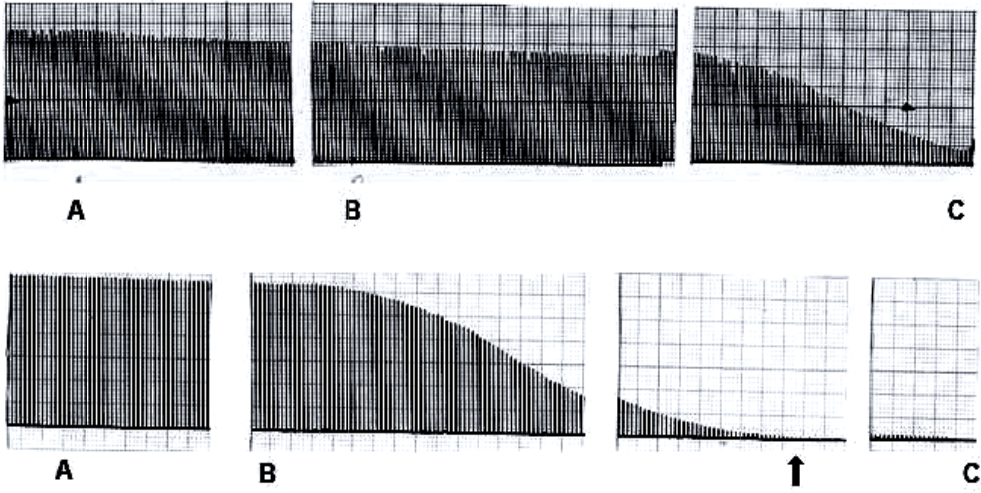
FIGURE 2 - Rocuronium effect (4 µg/mL) in the muscle response to indirect stimulation in rat phrenic nerve-diaphragm preparation exposed to lidocaine - 20 µg/mL (upper tracing) and racemic bupivacaine - 5.0 µg/mL (lower tracing). A: local anesthetic addition; B: rocuronium addition 30 minutes after local anesthetic; C: 60 minutes after rocuronium. The dart (lower tracing) shows the complete rocuronium blockade (26.8 ± 4.32 minutes)